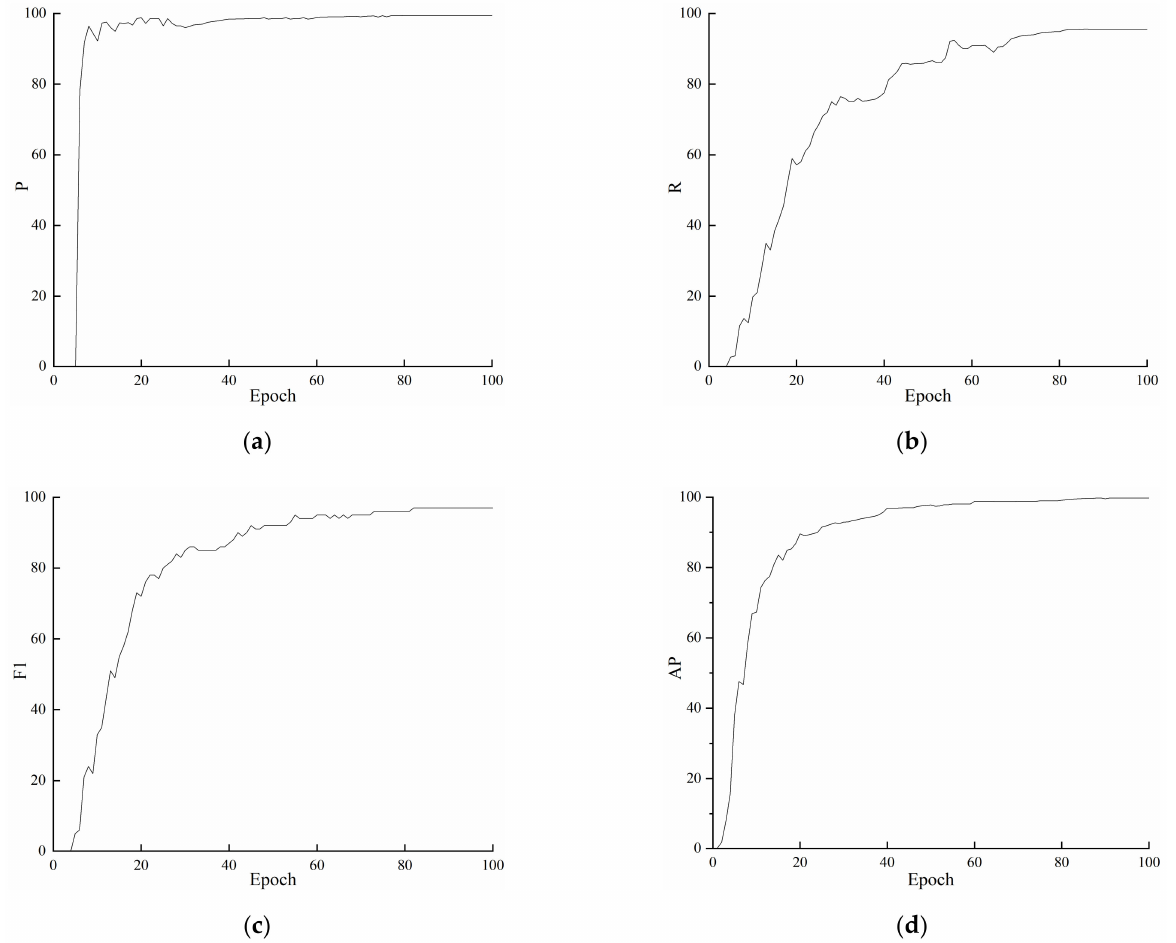
Figure 8. Variation of each index with training times: ( a ) Curve of P value changing with training times; ( b ) Curve of R value changing with training times; ( c ) Curve of F1 value changing with training times; ( d ) Curve of AP value changing with training